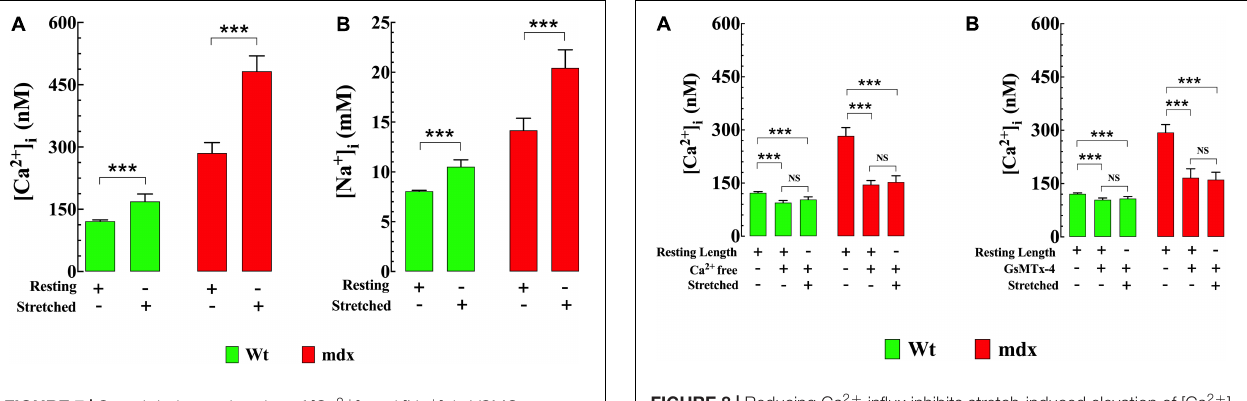
285 ± 25 nM, n = 25 to 482 ± 37 nM, n = 20 ( p < 0.001) ( Figure 7A ) and [Na + ] i by 43% from to 14 ± 1.2 mM, n = 19